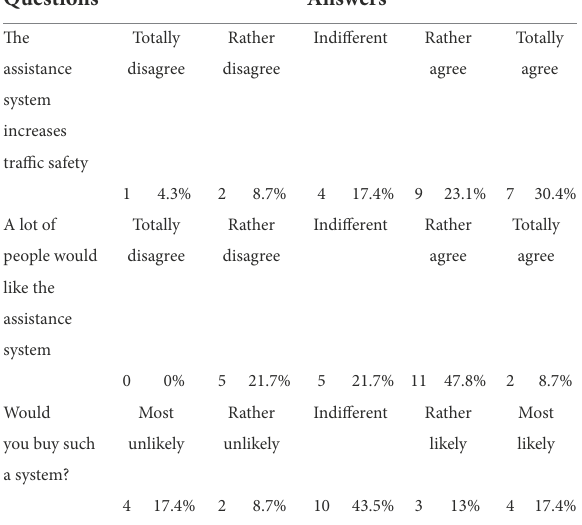
TABLE 1 Frequencies and percentages of answers to the three acceptance questions regarding the assistance system in the VR